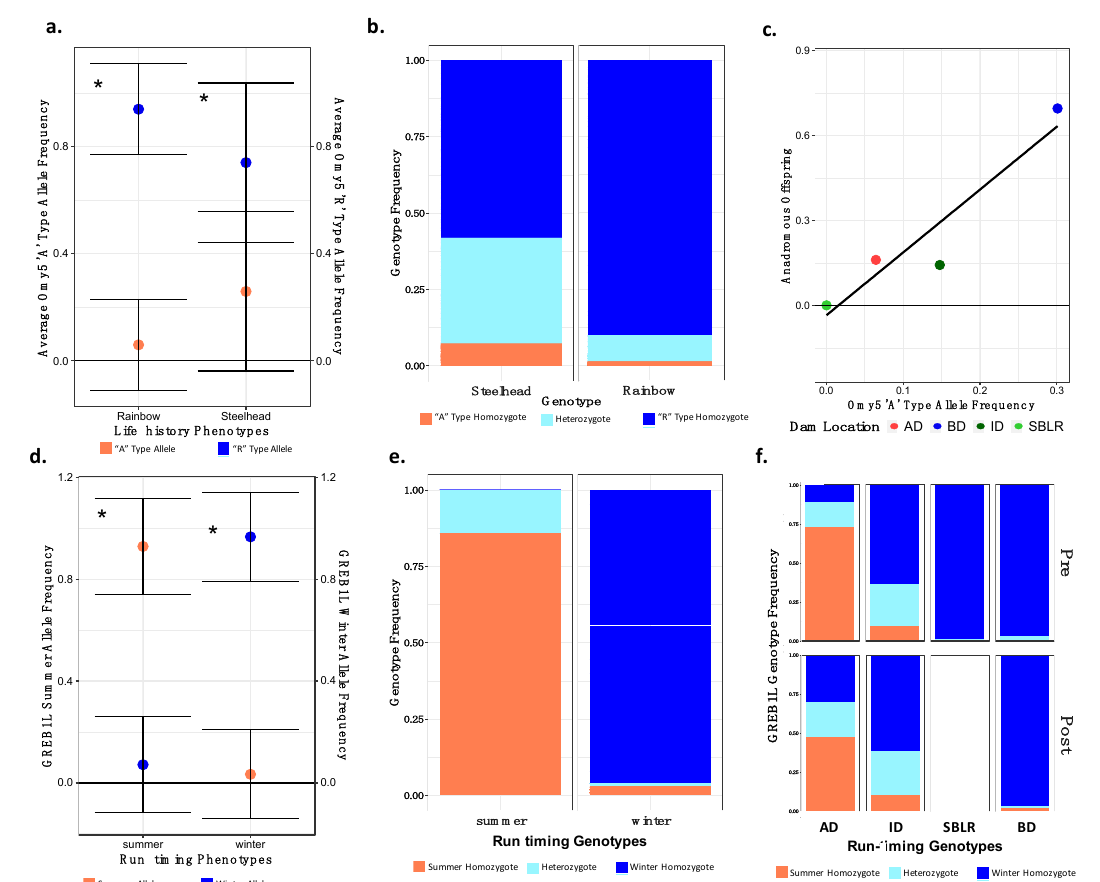
Figure 7. There were significant differences in the allelic and genotypic frequencies of the Omy5 ( a – c ) and the GREB1L variants ( d – f ) among populations and life histories. There were significant differences in the mean allele frequencies of the Omy5 locus allele frequencies between steelhead and unknown forms ( a ) and the frequency of the Omy5 “A” type allele frequency significantly explained life history phenotype ( b ). We also observed a strong correlation between the number of anadromous individuals from each population and the frequency of the “A” allele ( c ). The mean frequency of the GREB1L summer allele also varied significantly between summer- and winter-run steelhead ( d ), with the frequency of the homozygous summer genotype significantly explaining run timing ( e ), and inferred, ancestral population explaining a significant proportion of the variation in genotype both prior to and post-dam removal ( f ). Asterisks ( a , c ) indicate statistical significance ( α = 0.01)